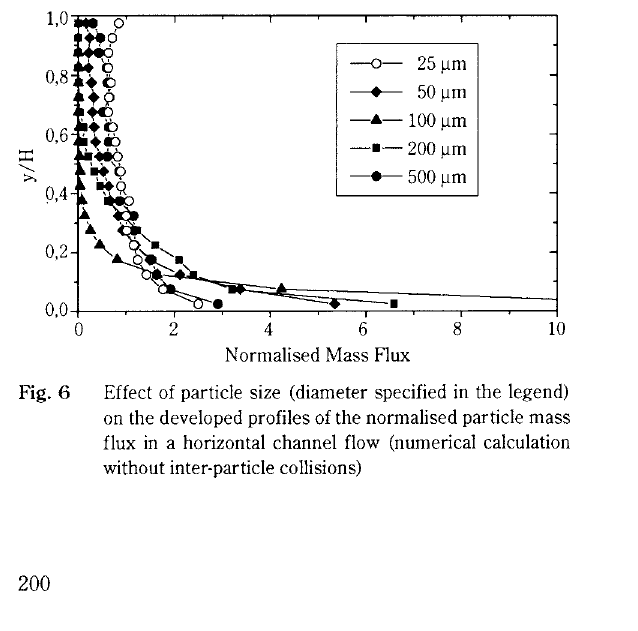
Normalised Mass Flux Effect of particle size (diameter specified in the legend) on the developed profiles of the normalised particle mass flux in a horizontal channel flow (numerical calculation without inter-particle